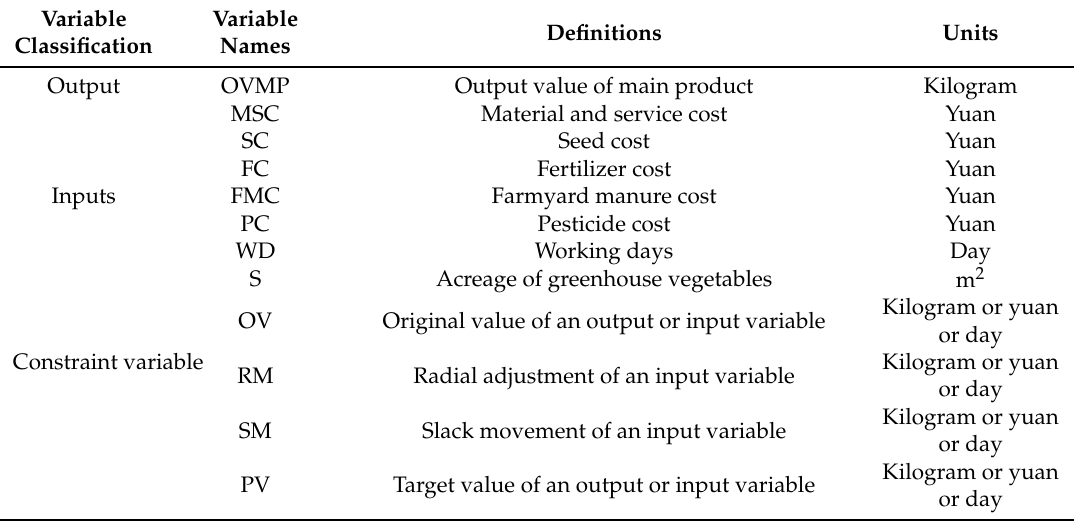
Table 1. Classification and description of